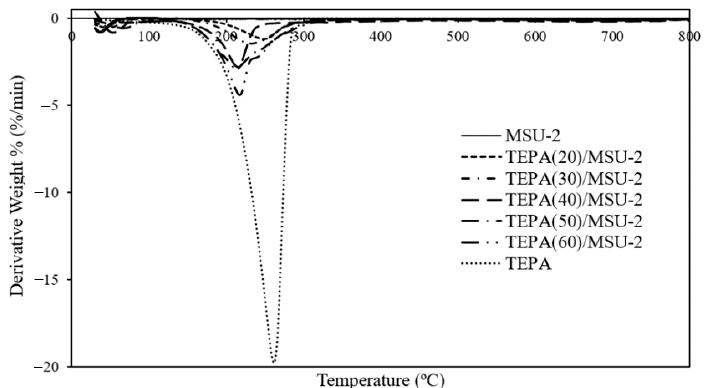
Figure 6. DTG curves of unfunctionalized MSU-2; MSU-2 functionalized with TEPA loadings of 20